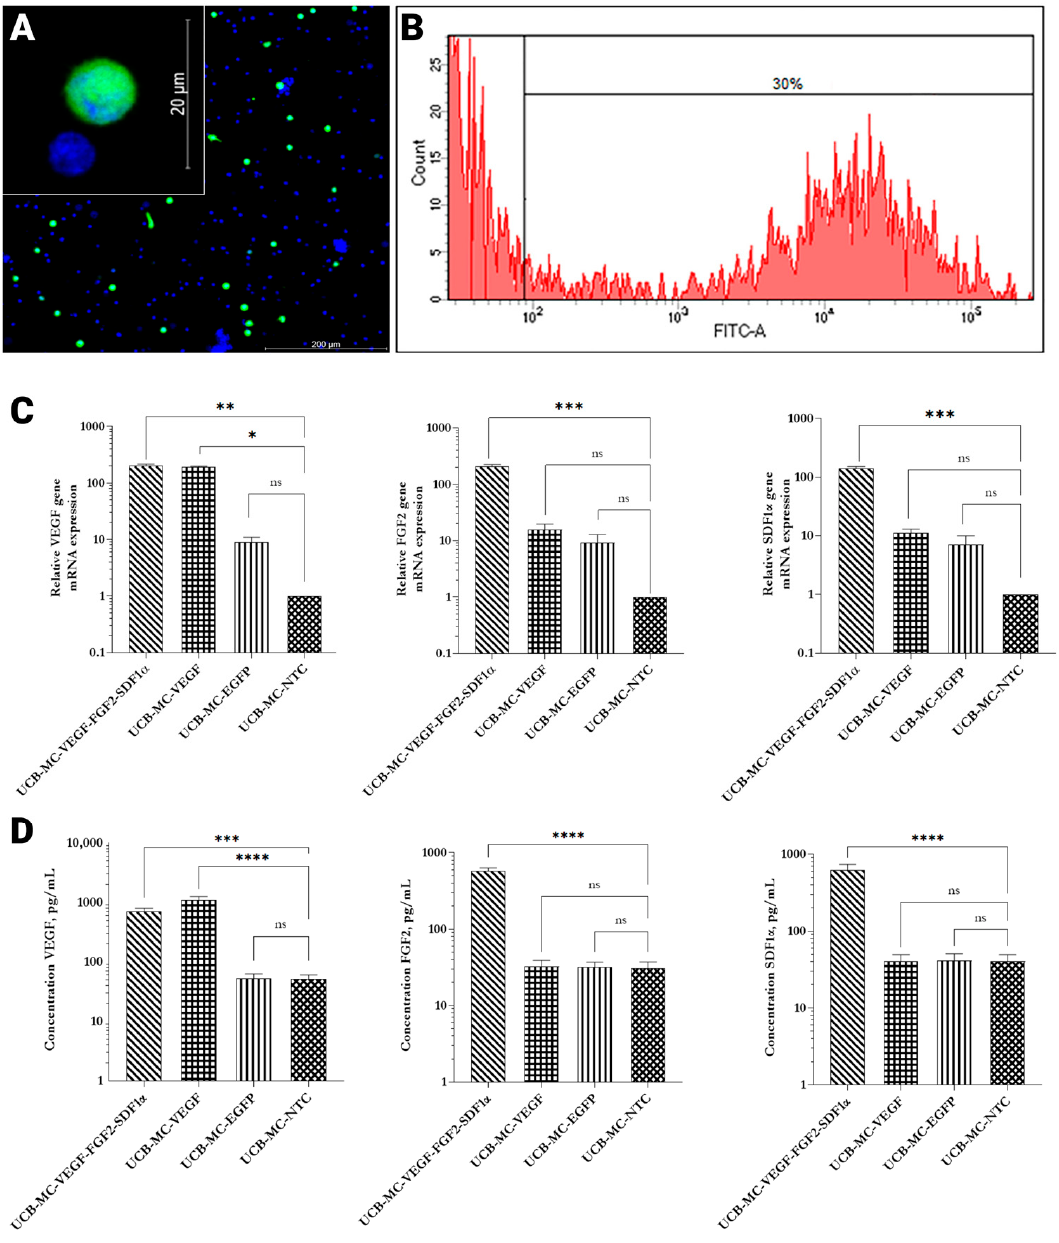
Figure 3. Analysis of transgenes expression in genetically modified UCB-MCs in vitro, 72 h post- transduction (MOI 10). ( A ) Fluorescent microscopy of EGFP+ cells (green fluorescence). Nuclei were stained with Hoechst 33342 (blue fluorescence). Scale bar 200 µ m, 20 µ m (inset). ( B ) Flow cytometry analysis of Ad-EGFP genetically modified UCB-MCs. Approximately 30% of genetically modified UCB-MCs exhibit green fluorescence. ( C ) Relative expression mRNA of therapeutic genes in genetically modified hUCB-MCs ( n = 3). ( D ) The concentration of secreted proteins VEGF, FGF, and SDF1 α in supernatants collected from genetically modified umbilical cord blood mononuclear cells ( n = 8). UCB-MC-VEGF-FGF2-SDF1 α —umbilical cord blood mononuclear cells modified with Ad-VEGF165, Ad-FGF2, and Ad-SDF1 α . UCB-MC-VEGF—umbilical cord blood mononuclear cells modified with AdVEGF165. UCB-MC-EGFP—umbilical cord blood mononuclear cells modified with Ad-EGFP. UCB-MC-NTC—non-treated cells. Data presented as average ± standard error (SE); p < 0.05 * statistically significant differences compared to control (** p < 0.01; *** p < 0.001; **** p < 0.0001 ns—non-significant).